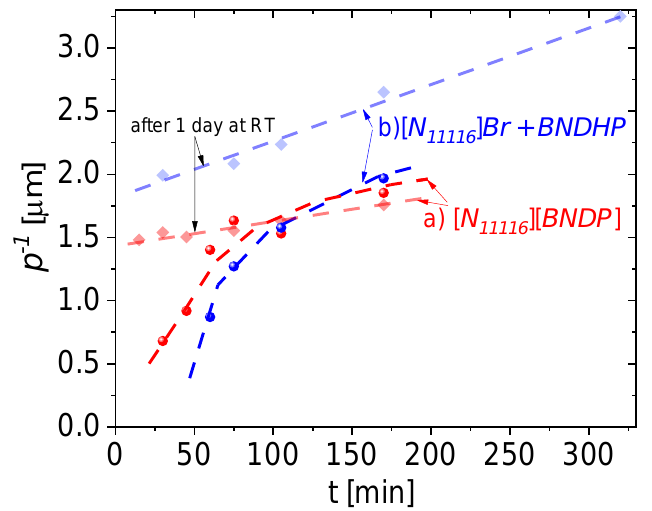
Figure 8. Dynamics of the inversed helical pitch of the mixtures of 1825 liquid crystal host doped with: (a) 9.3 ± 0.2 wt% of [ N 11116 ][ BNDP ] chiral salt and (b) 4.5 ± 0.4 wt% of BNDHP acid and about 4.6 ± 0.6 wt% of the [ N 11116 ] Br ( CTAB ) salt, with respect to the heating time at temperature of 150 °C. Bold and light points and lines are related to the samples measured at the day of preparation and one day after preparation, respectively. Dashed curves or lines are presented for guiding an eye.